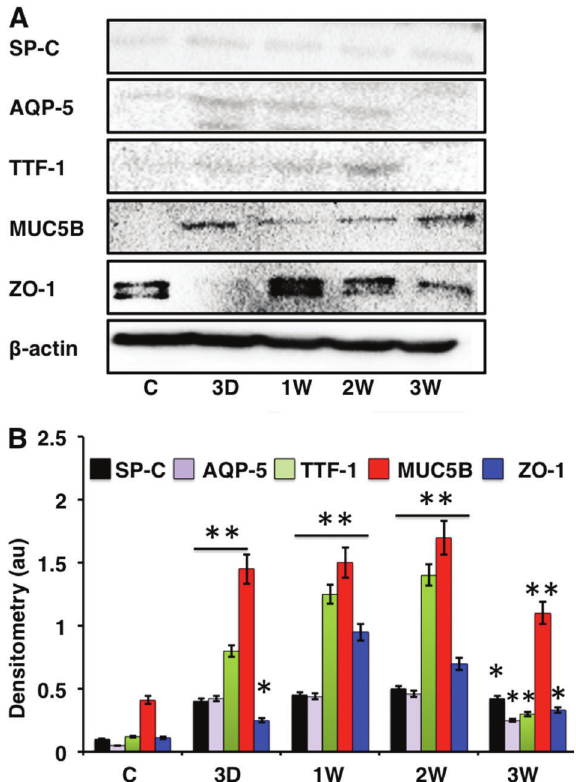
Figure 6. Protein of several key cell-speci fi c markers of alveolar epithelial cells in A549 cell air-liquid interface (ALI) cultures at 3 days, 1 week, 2 weeks and 3 weeks were examined by an immunoblotting assay using speci fi c antibodies. A , Representa- tive blots of immunoblotting assay showing signi fi cantly higher levels of AECI cell type markers AQP-5, TTF-1, and epithelial cell proteins MUC5B and ZO-1 observed in ALI cultures compared to submerged cultures of A549 cells (control, C). However, AECII cell type-speci fi c marker SPC was only moderately increased in ALI cultures compared to submerged cultures of A549 cells. B , Densitometry values are reported as fold-change for SPC, AQP-5, TTF-1, MUC5B and ZO-1 proteins over b -actin. Data in B are reported as means ± SD from 3 independent experiments (n=3). D: days; W: week(s). *P o 0.05 and **P o 0.01 compared to the submerged culture control